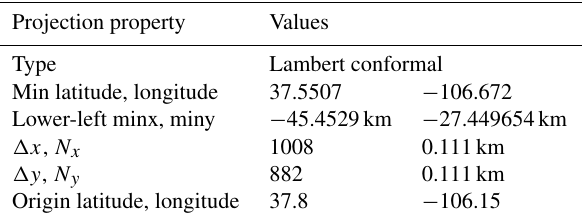
Table 3. Projection information for Grib2 for WRF LES grid